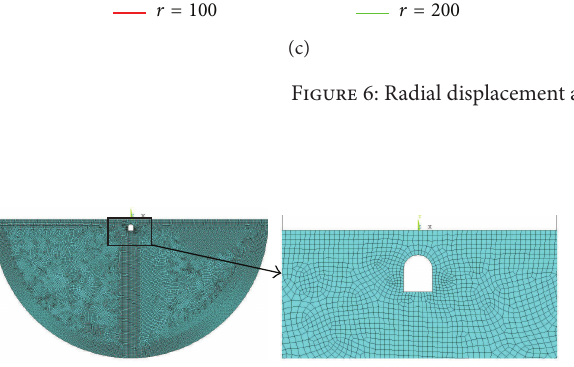
Figure 7: Mesh distribution in the case of cavity 3C.